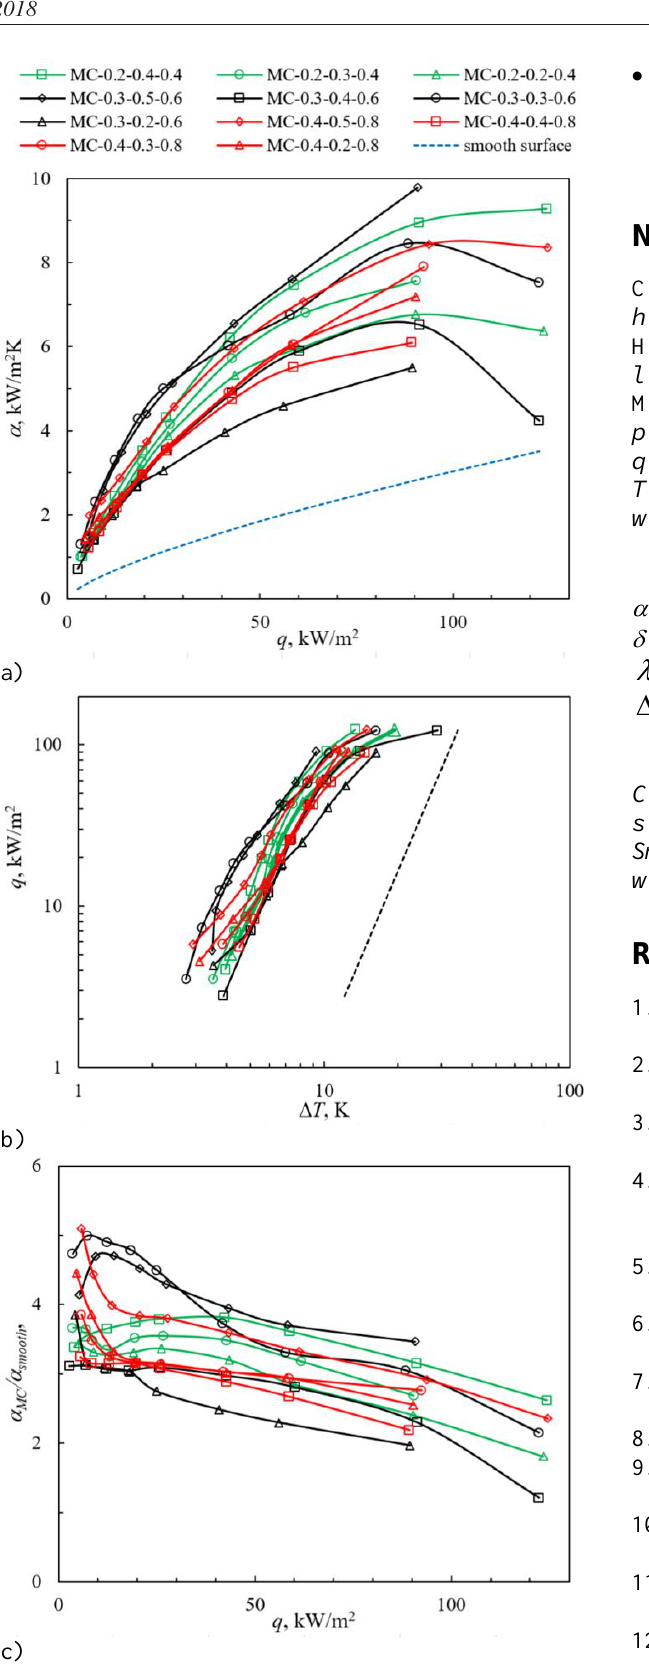
Fig. 4. Boiling curves for FC-72, a) heat transfer coefficient vs. heat flux, b) heat flux vs. temperature difference, c) data in the non-dimensional form for MC